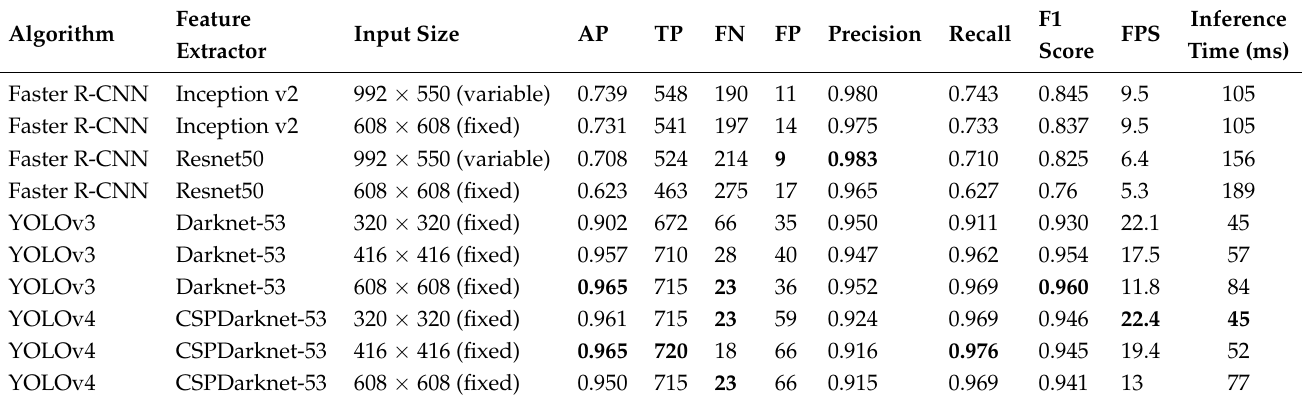
Table 10. Detailed results of different configurations of YOLOv3, YOLOv4, and Faster R-CNN, on the PSU (Prince Sultan University) dataset. The default configuration of Faster R-CNN allows for a variable input size that conserves the aspect ratio of the image. In this case, the input size shown is an average. The best results are shown in bold.